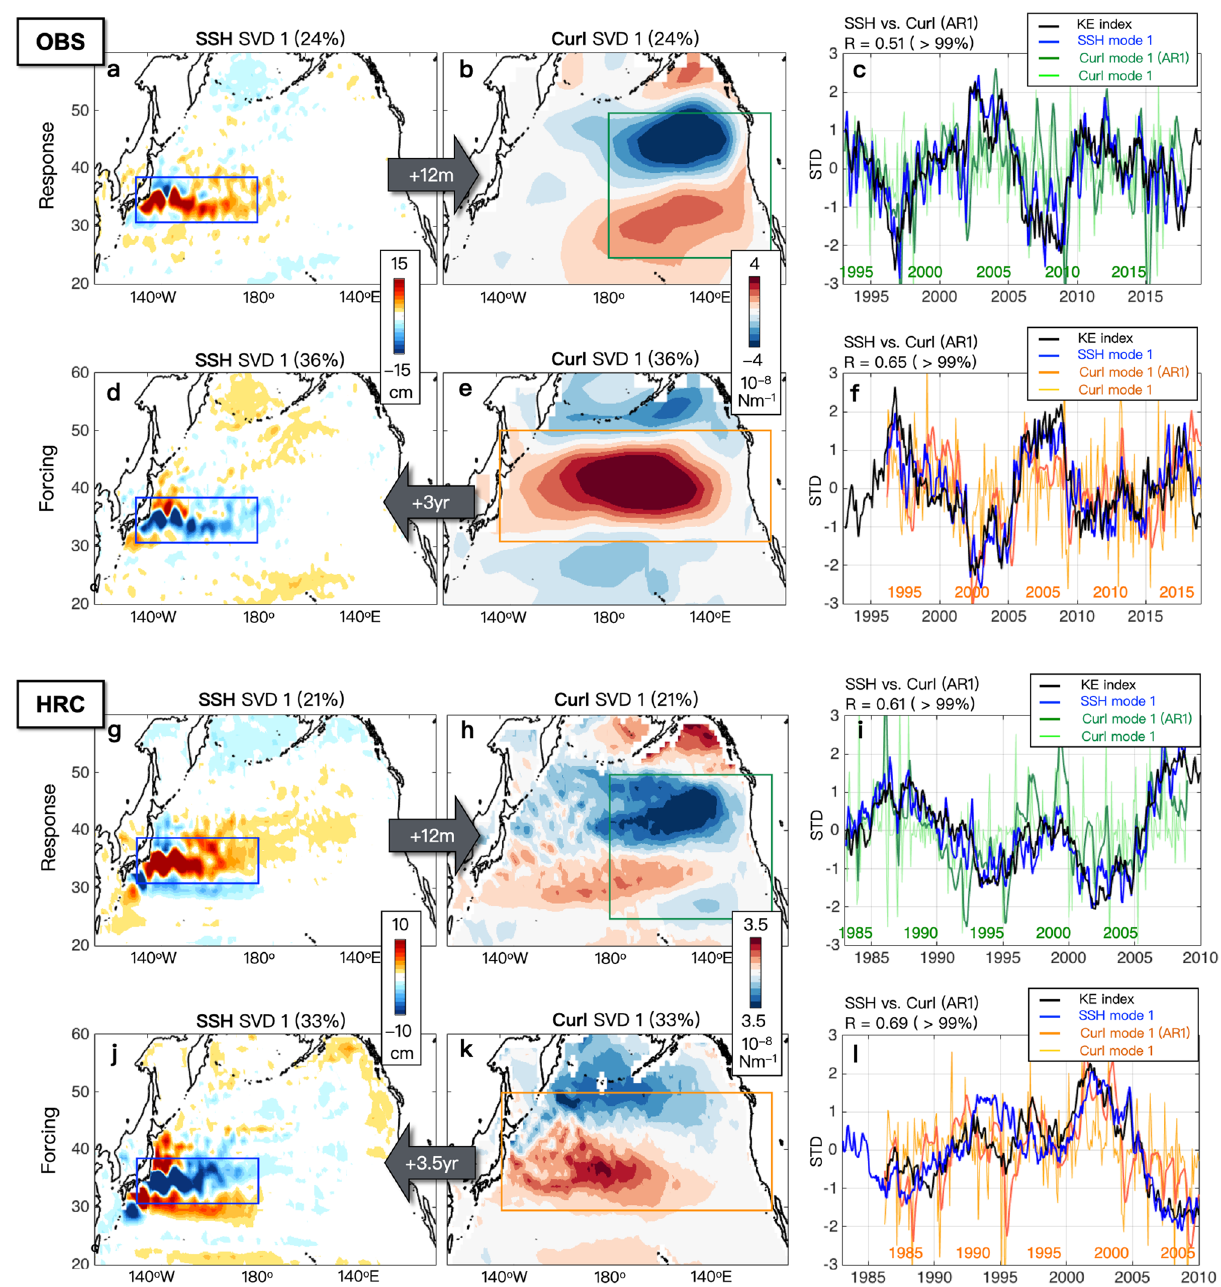
Figure 2. Spatial and temporal patterns of KE dynamics (KE atmospheric response and forcing of KE) based on singular value decomposition (SVD) analysis between KE SSH and midlatitude wind stress curl with lead/lag times. Patterns of the leading SVD mode between the observed ( a ) SSH over the KE region (blue box) and ( b ) 12mon-lagged Curl over the downstream region (green box) for the recent period. ( c ) The associated time series of corresponding SSH and SVD modes. (d-f) Same as in ( a – f ), but for with mon-leading Curl. The same analysis was repeated with HRC in ( g – i ) and ( j – l ). The figures are provided using MATLAB R2017a (https:// www. mathw orks. com/ produ cts/ new_ produ cts/ relea se201 7a.